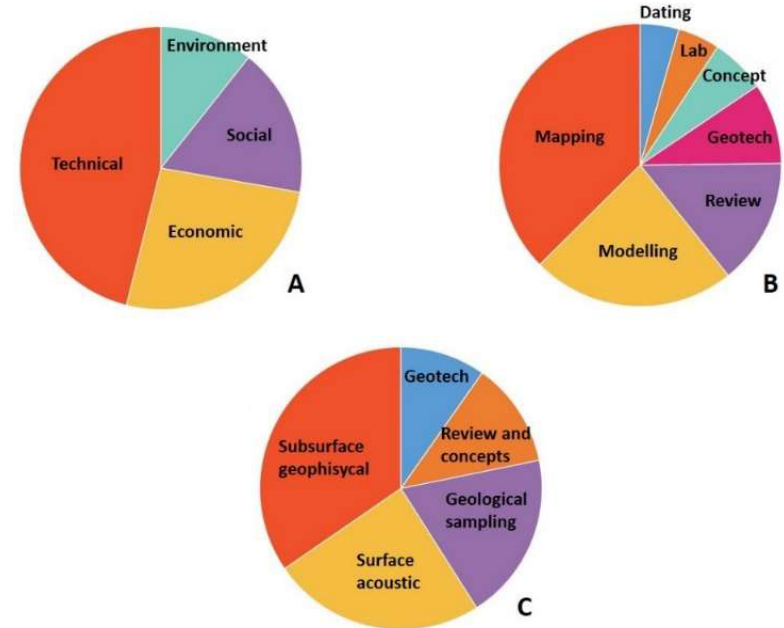
Figure 12. Qualitative and quantitative results of the research characterizations parameters. ( A ): Number of each perspective in peer-reviewed publications between 1982 and 2016. ( B ): Number of each approach in peer-reviewed publication between 1982 and 2016. ( C ): Number of each of the instruments and techniques in peer-reviewed publication between 1982 and 2016.